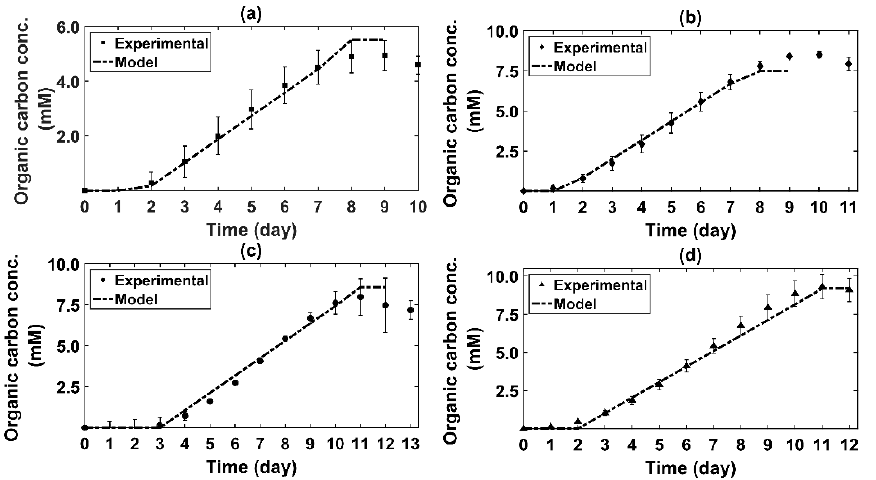
Figure 8. Comparison between experimental results and predicted values from the proposed kinetic model, for the determination of total organic carbon concentration for different initial nominal concentrations of NaHCO 3 : ( a ) 18, ( b ) 28, ( c ) 40, and ( d ) 60 mM.